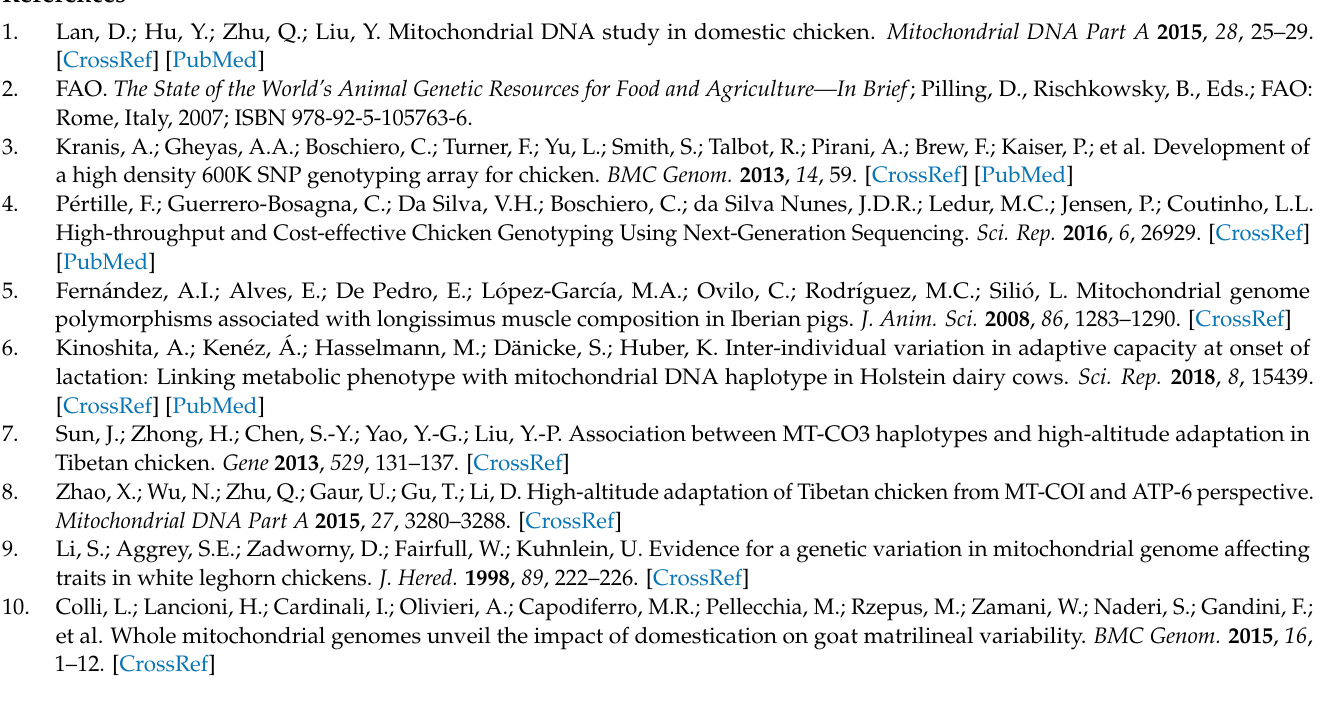
Table N2. p -values of the comparison of body weight and feed intake under high phosphorus concentrations in the feed.